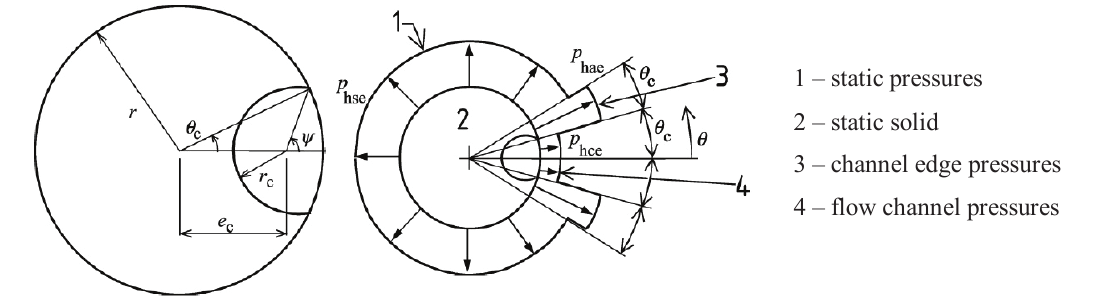
Fig. 2. Non-centric flow channel during emptying and distribution of pressure on the silo wall [12] Figure 2: Non-centric flow channel during emptying and the distribution of pressure on the silo wall, according to Eurocode 1, Part 4 a)